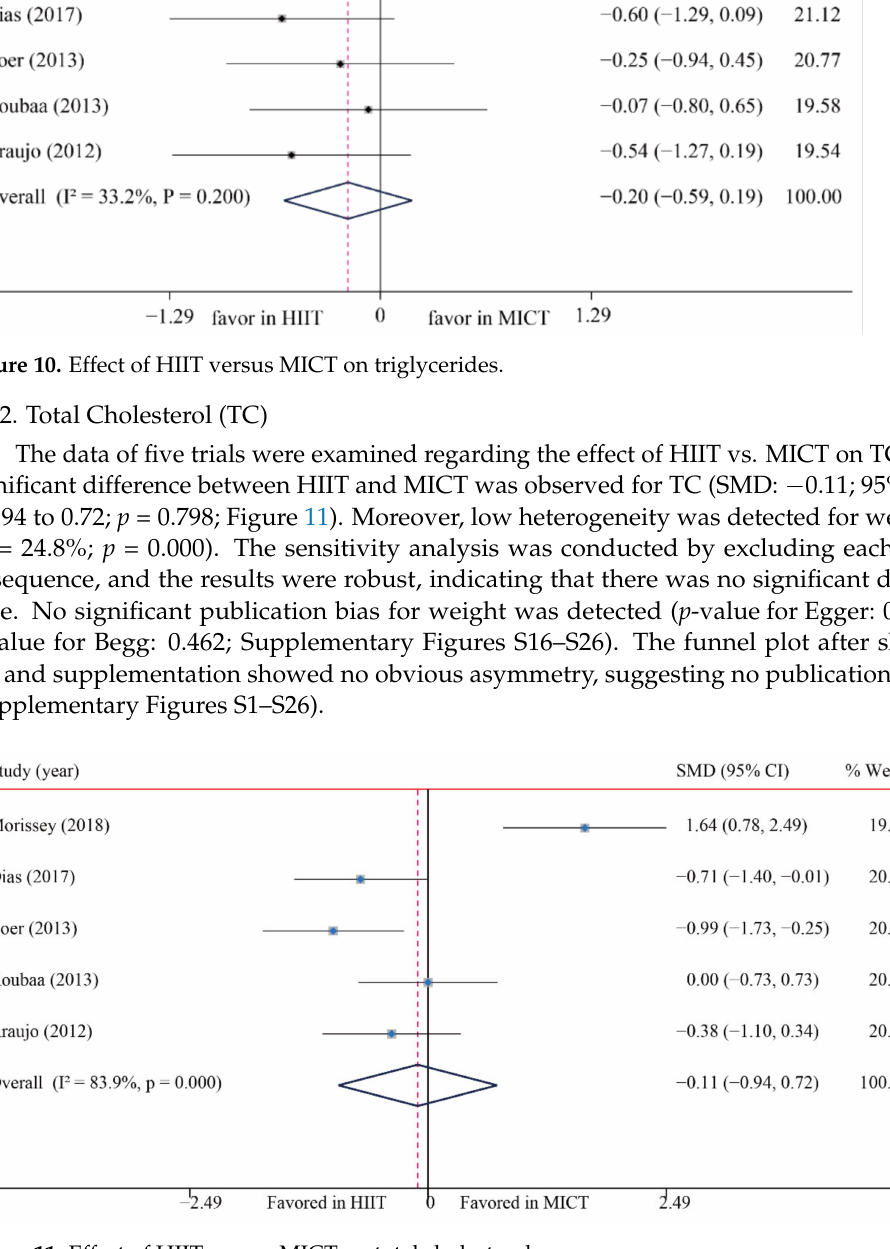
Figure 11. Effect of HIIT versus MICT on total